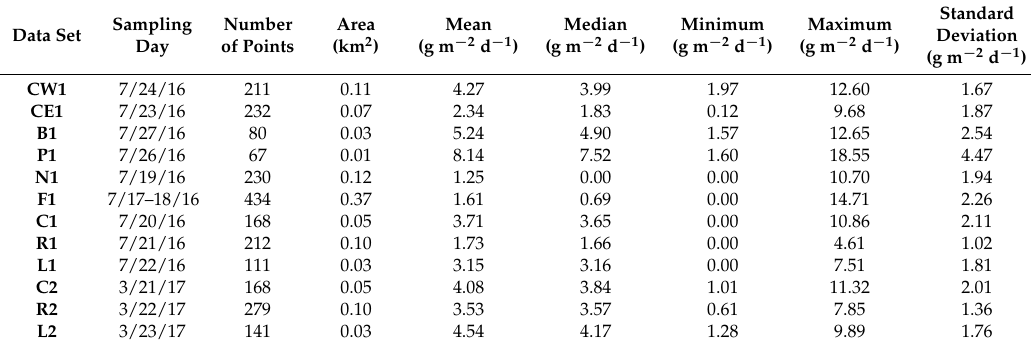
Table 2. Descriptive statistics of Corvo and Flores lakes’ CO 2 flux data (CW1—Caldeir ã o West,